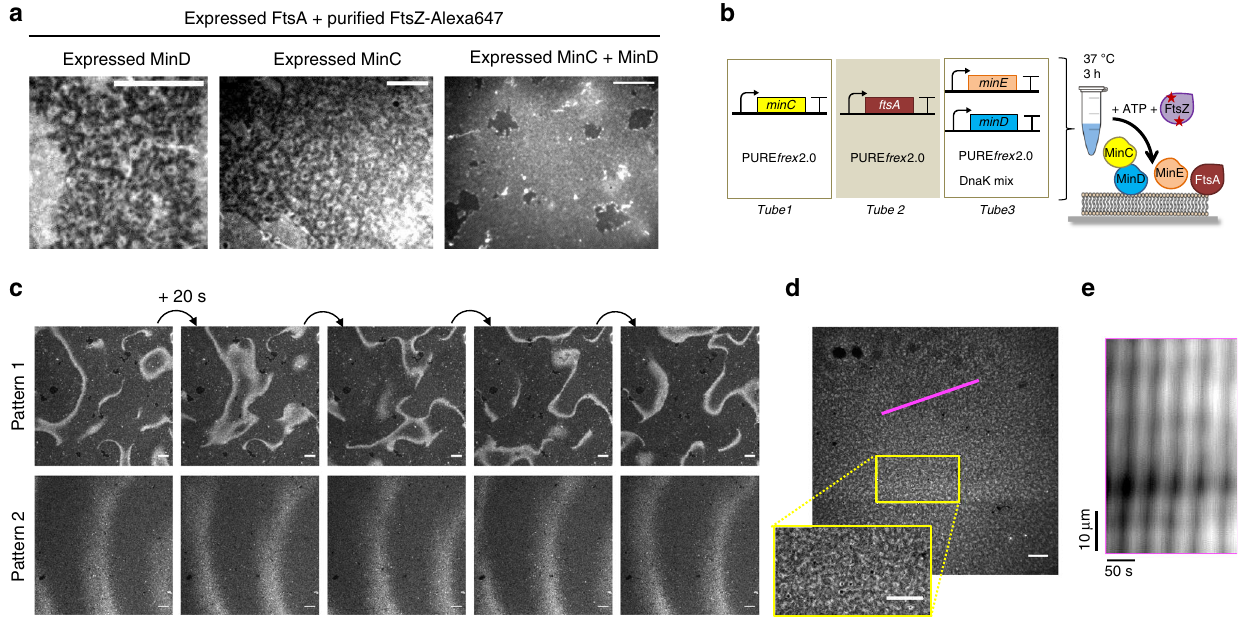
Fig. 6 Cell-free expressed MinDE(C) regulates FtsZ spatial organization. a Ring-like structures composed of puri fi ed FtsZ-Alexa647 and expressed FtsA can assemble on an SLB. The ability of separately expressed MinC and MinD, or co-expressed MinC/D to inhibit formation of FtsA-FtsZ rings was investigated. A representative fl uorescence image is shown for each condition. An 8 × 8 fi elds of view montages are shown in Supplementary Figs. 12 – 14. Scale bars are 10 µ m. b Schematic of the MinCDE and FtsA-FtsZ-coupled SLB assay. c Two time-series images of FtsZ-Alexa647 dynamic patterns. Scale bars are 10 µ m. The corresponding videos are shown in Supplementary Movie 10. An 8 × 8 fi elds of view montage of pattern 1 is shown in Supplementary Fig. 15. d Cytoskeletal pattern of expressed FtsA and puri fi ed FtsZ-Alexa647 combined with MinDE. In the absence of MinC, the FtsZ bundle network is maintained but traveling waves of FtsZ-Alexa647 are also visible (see Supplementary Movie 11). Scale bars are 10 µ m. e Kymograph of the FtsZ-Alexa647 signal along the magenta line shown in d . The images were preprocessed to fi lter out small-scale features